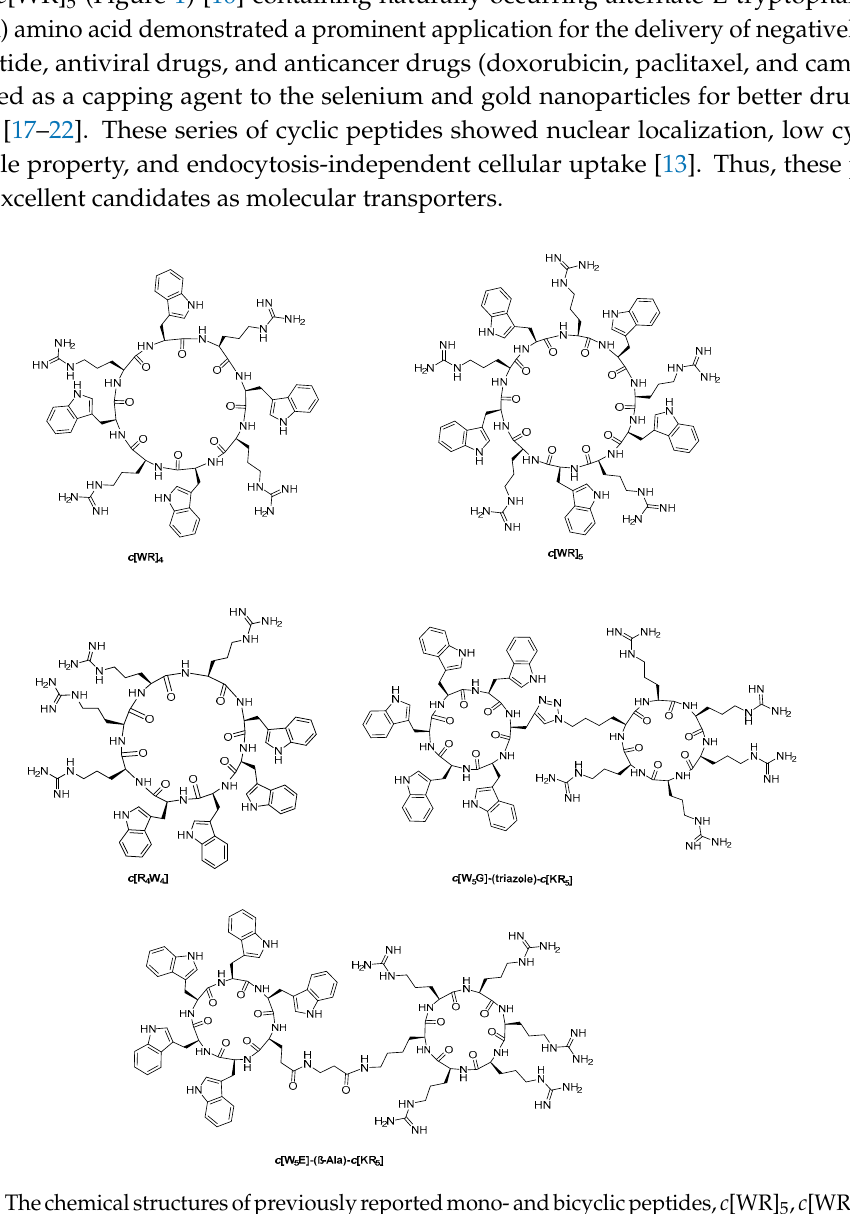
Figure 1. The chemical structures of previously reported mono- and bicyclic peptides, c [WR] 5 , c [WR] 4 [16], c [R 4 W 4 ] [23], and ( c [W 5 G]-(triazole)- c [KR 5 ], and c [W 5 E]-( β -Ala)- c [KR 5 ])